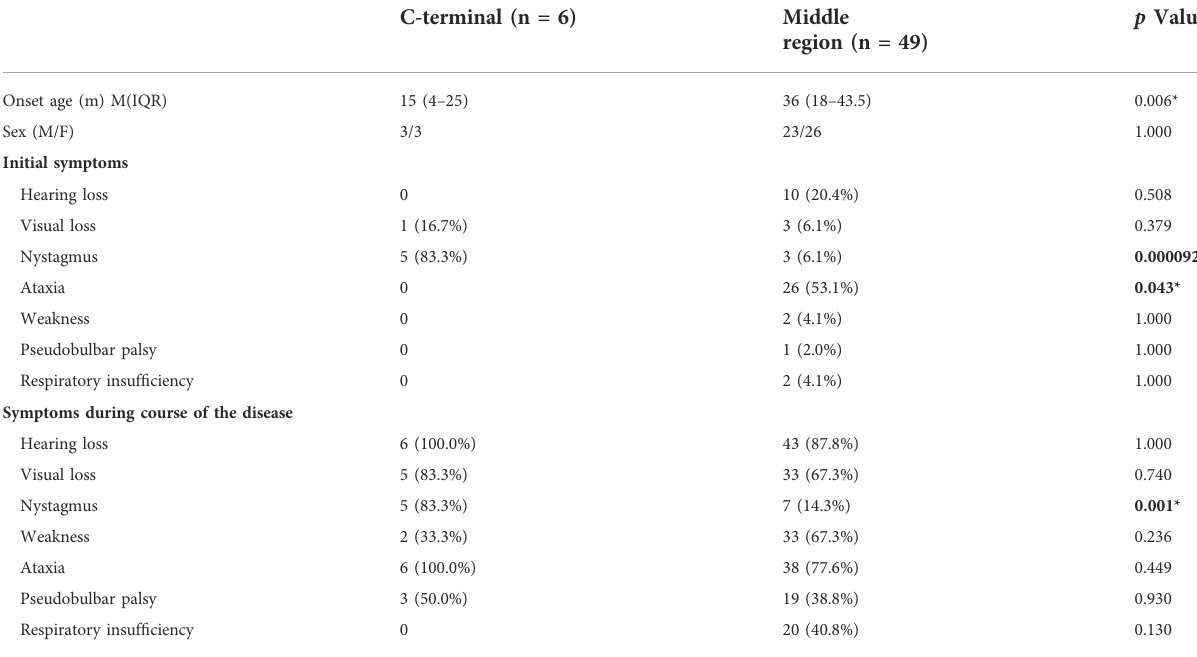
TABLE 3 Comparison of the clinical characteristics of patients with missense mutations in different positions in the SLC52A2